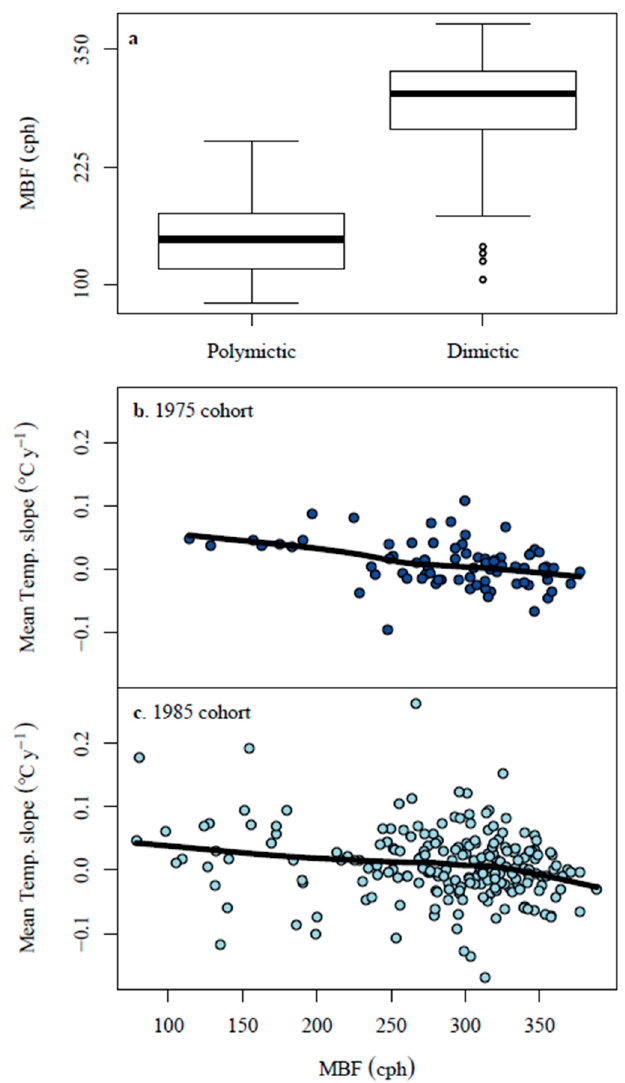
Figure 4. ( a ) The median buoyancy frequency (MBF) from the entire multi-year record of NENA lakes for each lake with the clear identification of polymictic or dimictic mixing regimes. Correlation of MBF with the mean temperature slope for ( b ) 1975 and ( c ) 1985 cohorts. The LOESS line has been added to visualize the relationship. In the boxplots, boxes span the first through third quartiles with the median trend represented by the thick center line with whiskers adding the ±1.5 interquartile range to the boxes. Open circles are individual points that fall outside that span.